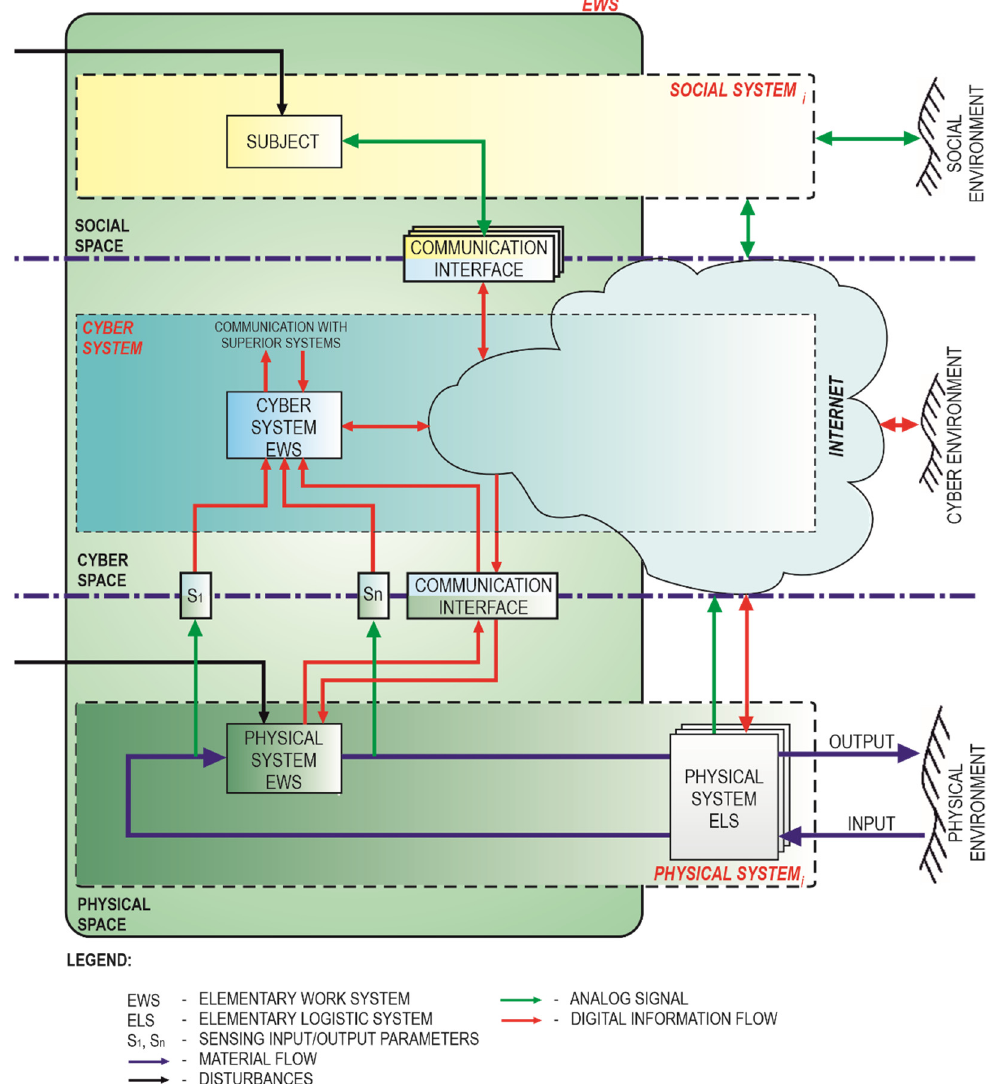
Figure 9. Model of the cyber-physical elementary work system [3].